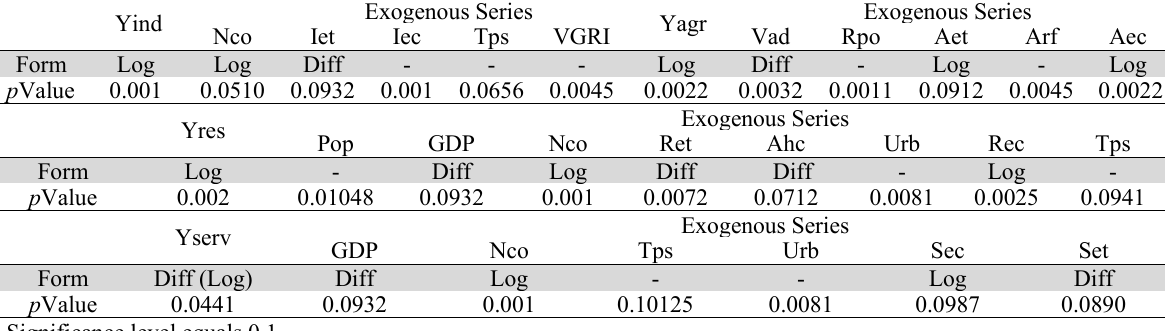
The results of unit root test for response times series and their selected transformation form Exogenous Series Yind